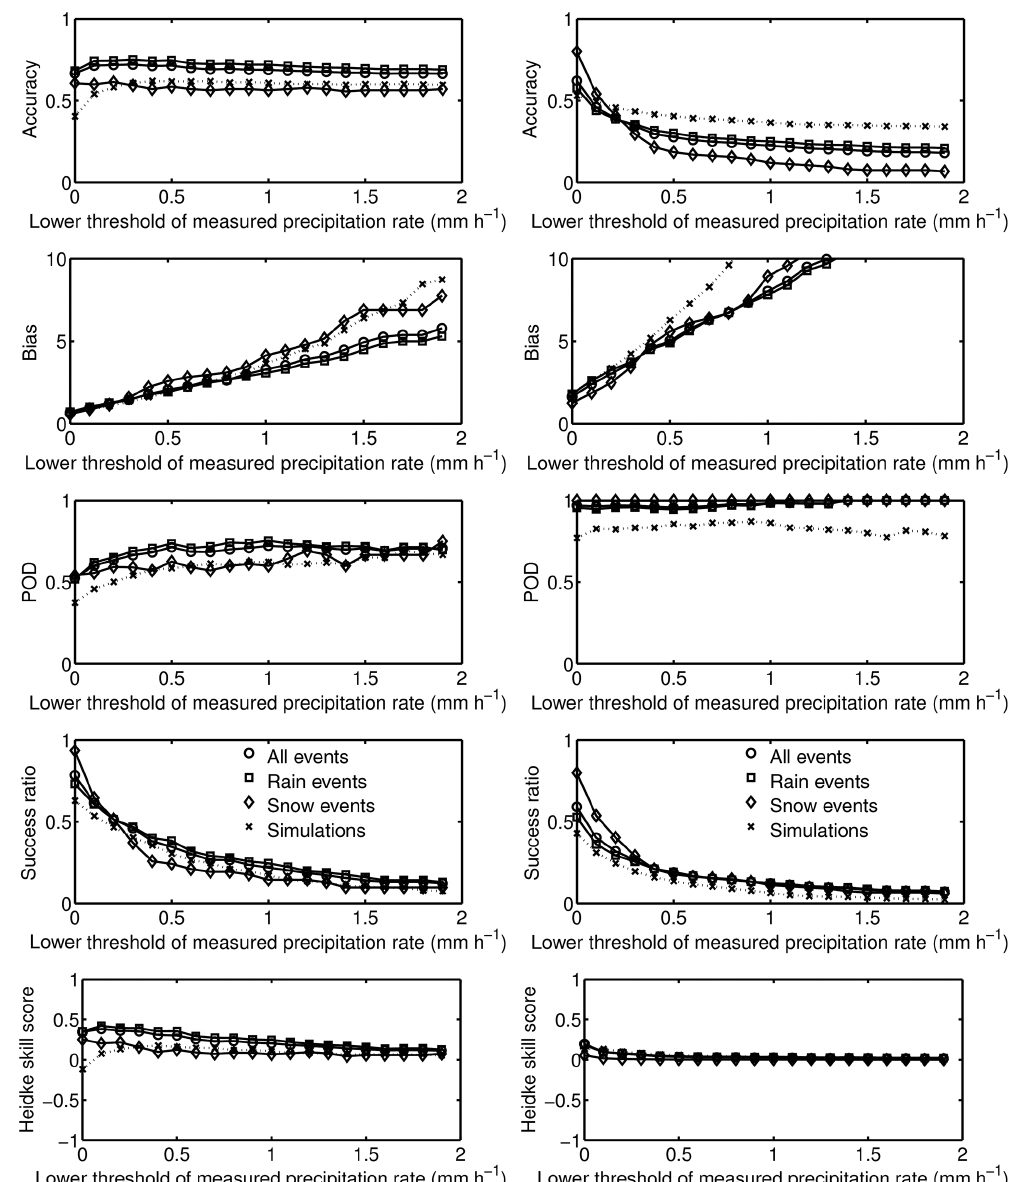
Figure 4. Accuracy, bias score, hit POD, success ratio and Heidke skill score (from top to bottom) against precipitation measurements for the period 1995–1997 (left HOAPS, right ERA-Interim) as a function of a lower threshold applied to the measurements.